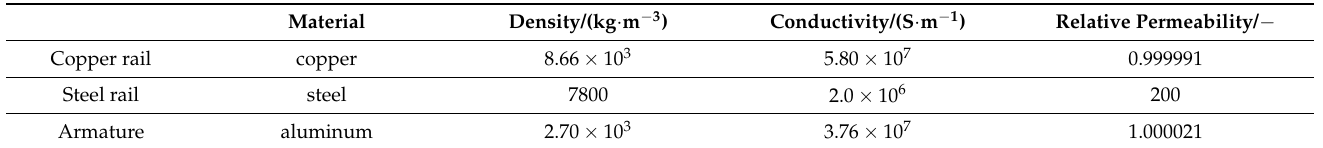
Table 1. Electromagnetic launcher material properties.